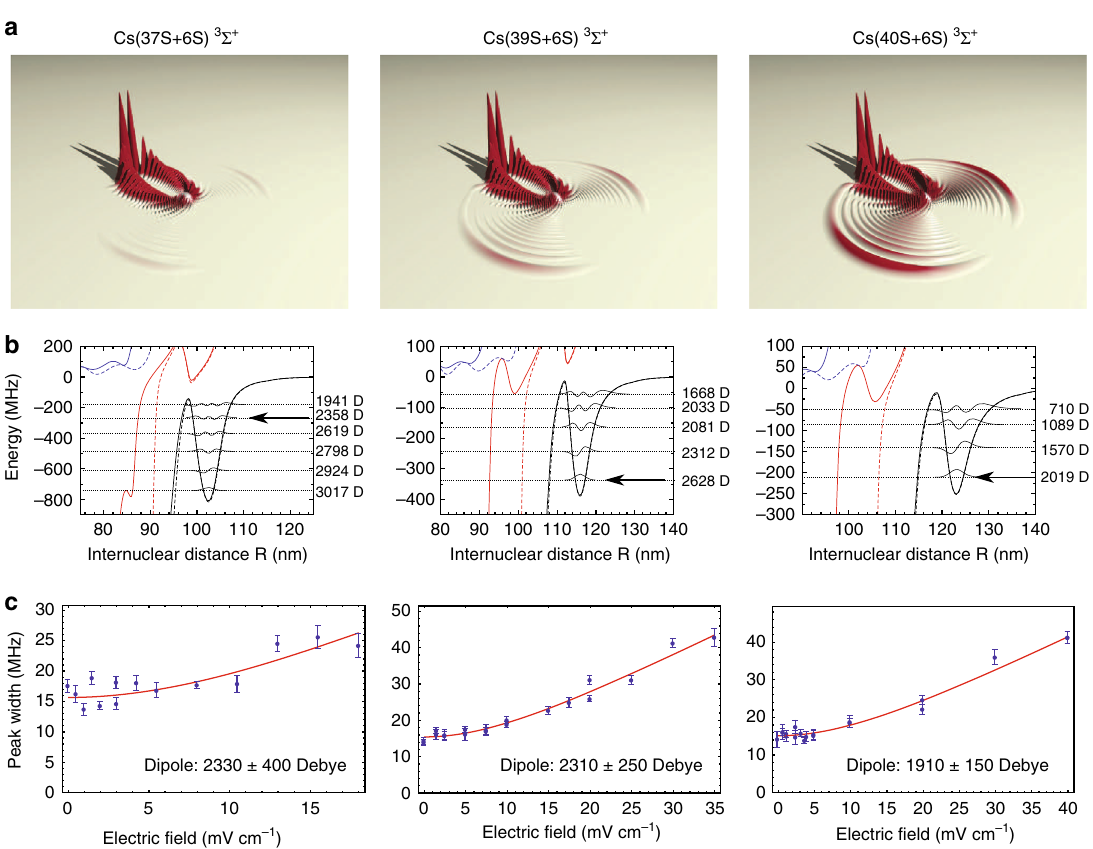
Fig. 2 Trilobite Rydberg molecules in an ultracold Cs gas. a Calculated electron density distributions for the 3 Σ + states of Cs correlating to 37 s + 6 s , 39 s + 6 s , and 40 s + 6 s . b The corresponding potential energy curves for the states shown in a with calculated vibrational levels. c The broadening of the vibrational levels indicated by an arrow in b as a function of applied electric fi eld. The changes in the lineshape as a function of electric fi eld are used to determine the dipole moments indicated in the fi gure. Figure from ref. 34 . Reprinted with permission from